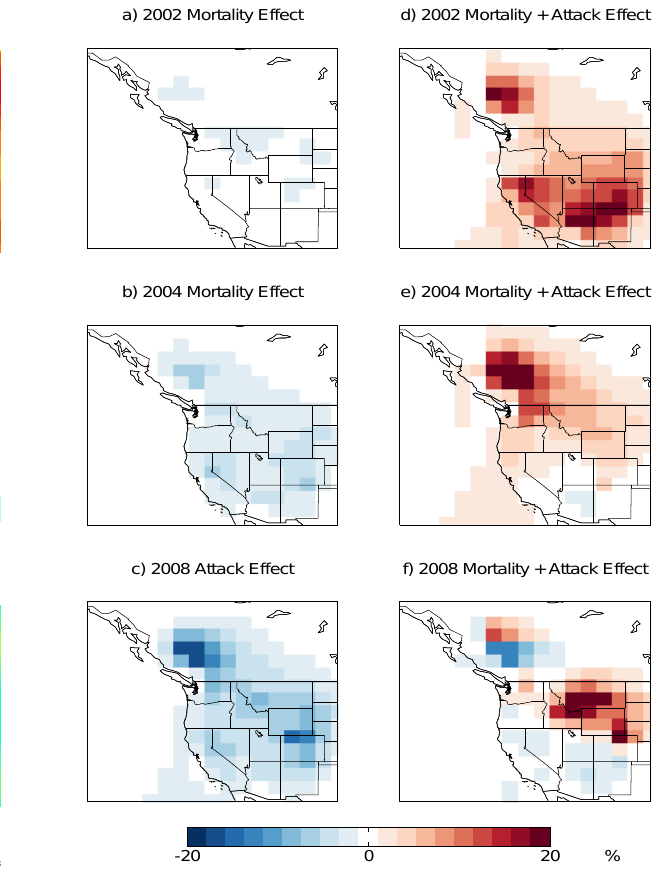
Fig. 7. Baseline summer-mean simulated concentrations of SOA from (a) 3-carene, (b) β -phellandrene, (c) α -pinene, (d) β -pinene, (e) p-cymene, and (f) sabinene. Color bar is saturated at 1µgm − 3 .